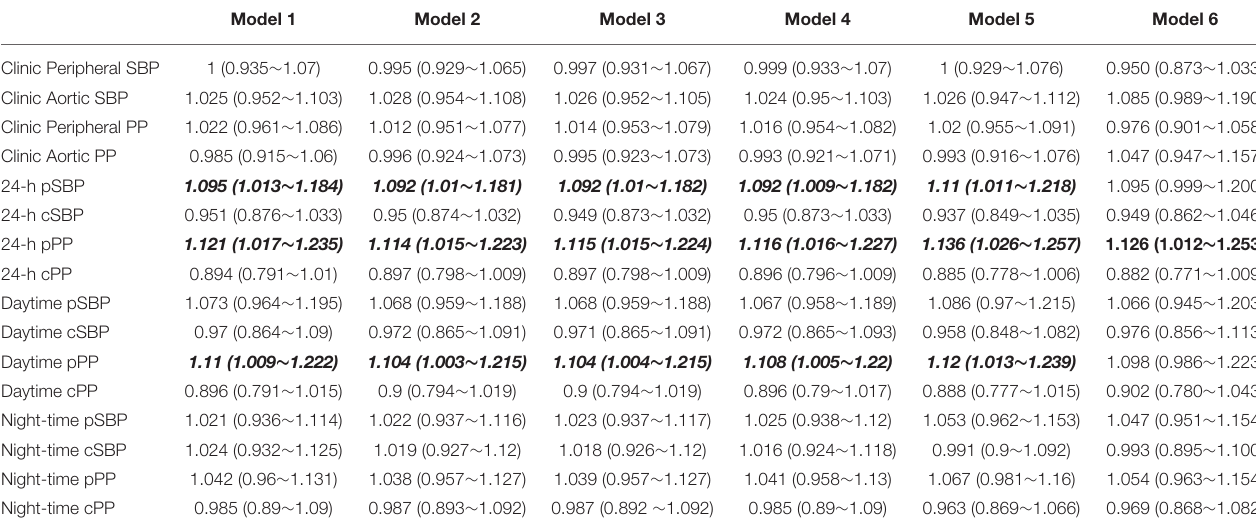
TABLE 3 | Odds ratios and 95% confidence intervals for each mmHg increase of the association of each blood pressure value with the presence of Hypertension-mediated organ damage.